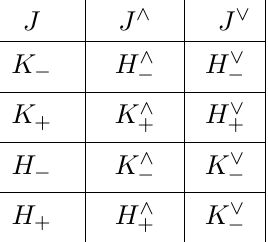
Table 2 . Action of the mirror symmetry maps on N = 4